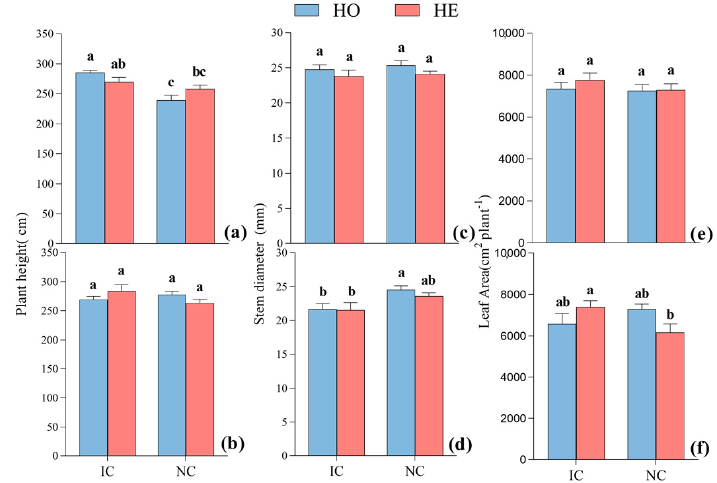
Figure 3. Effect of nitrogen distribution pattern and intraspecific competition on maize plant height, stalk thickness, and leaf area. ( a ) Plant height at flowering stage. ( b ) Plant height at mature stage. ( c ) Stem diameter at flowering stage. ( d ) Stem diameter at mature stage. ( e ) Leaf area at flowering stage. ( f ) Leaf area at mature stage. Values are means ± standard error of the mean. Treatments with different lowercase letters are significantly different at p < 0.05, the same as below. Table 2. Analysis of variance for maize yield, growth parameters, and root traits in flowering stage and mature stage (F value). Flowering Stage Mature Stage ND